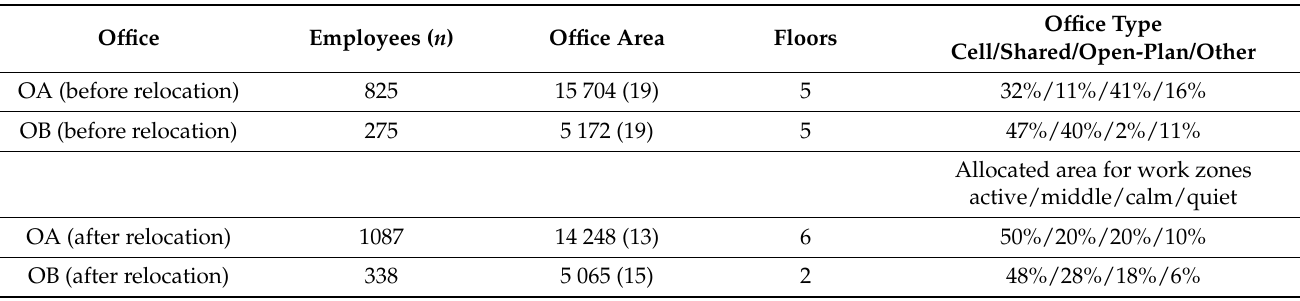
Table 1. Description of office parameters (data based on company reports) in office A (OA) and office B (OB) before and after relocation to ABW. Office area given as a total and per employee (in parentheses).